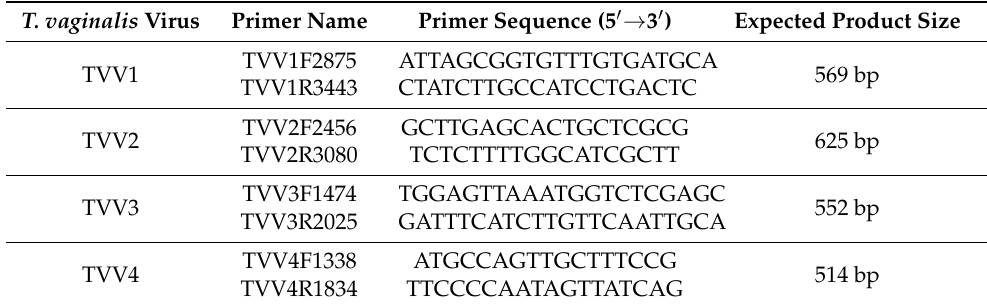
Table 4. Primers used for TVV determination.